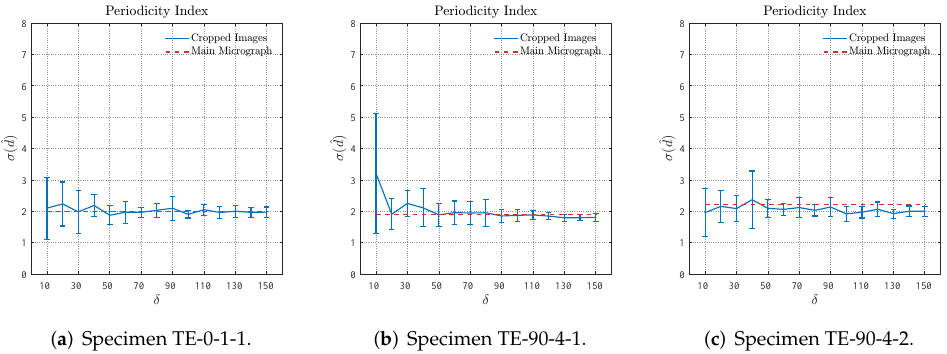
Figure 11. Standard deviation of nearest neighbor distance ˆ d computed for different sizes of cropped